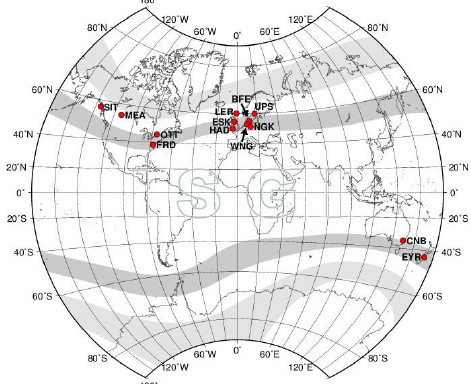
Table 1. Solar X-ray emission classes (Koskinen, 2011).